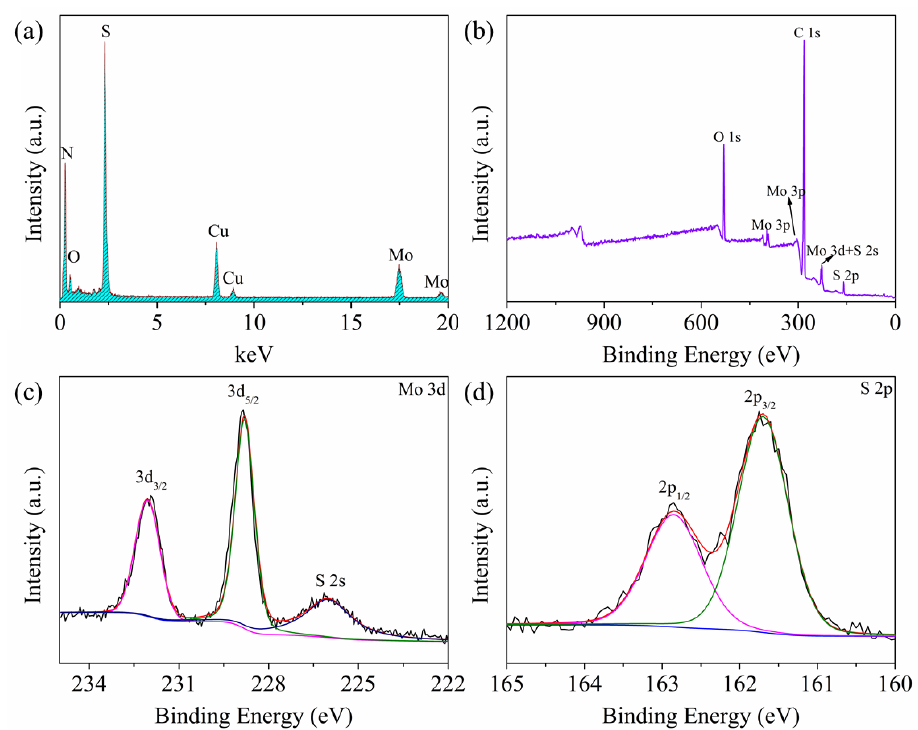
Figure 2. ( a ) Energy-dispersive X-ray spectrometry (EDX) spectrum of the WS-MSQDs. ( b ) X-ray photoelectron spectroscopy (XPS) image of the WS-MSQDs. The high-resolution XPS spectra of ( c ) Mo 3d and ( d ) S 2p.